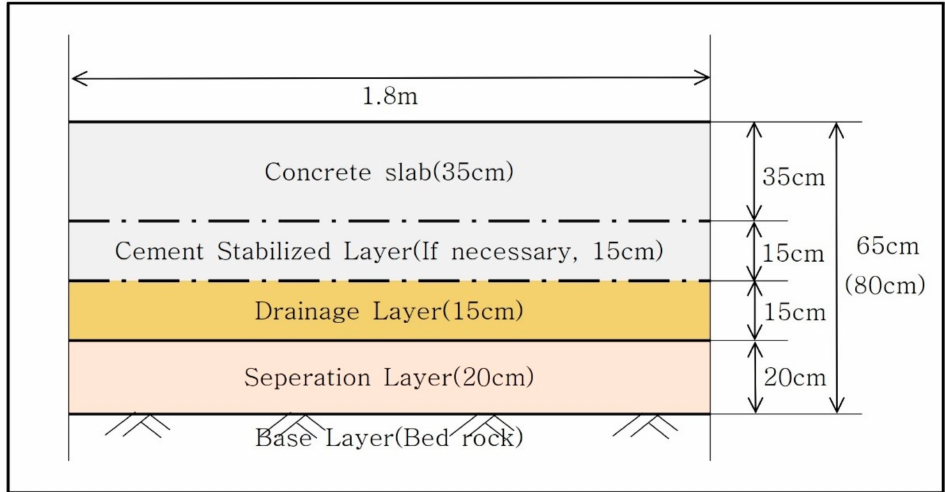
Figure 8. Runway rapid repair